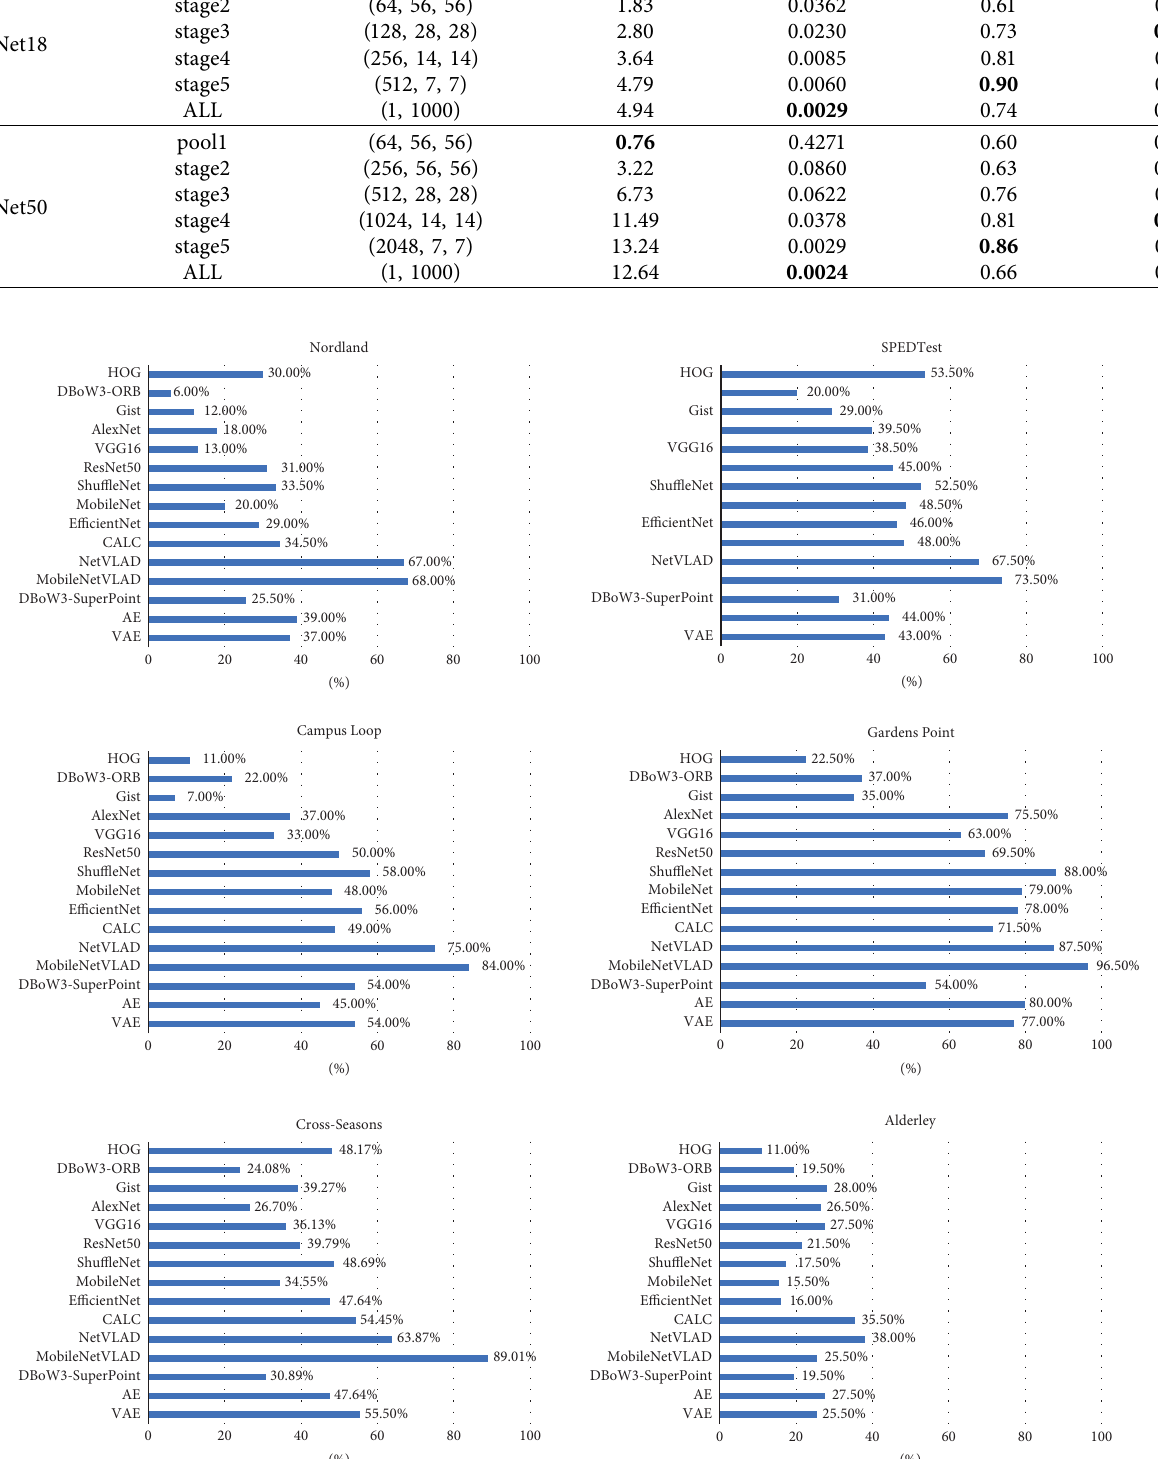
Figure 4: Te values of Recall@1 for 15 global